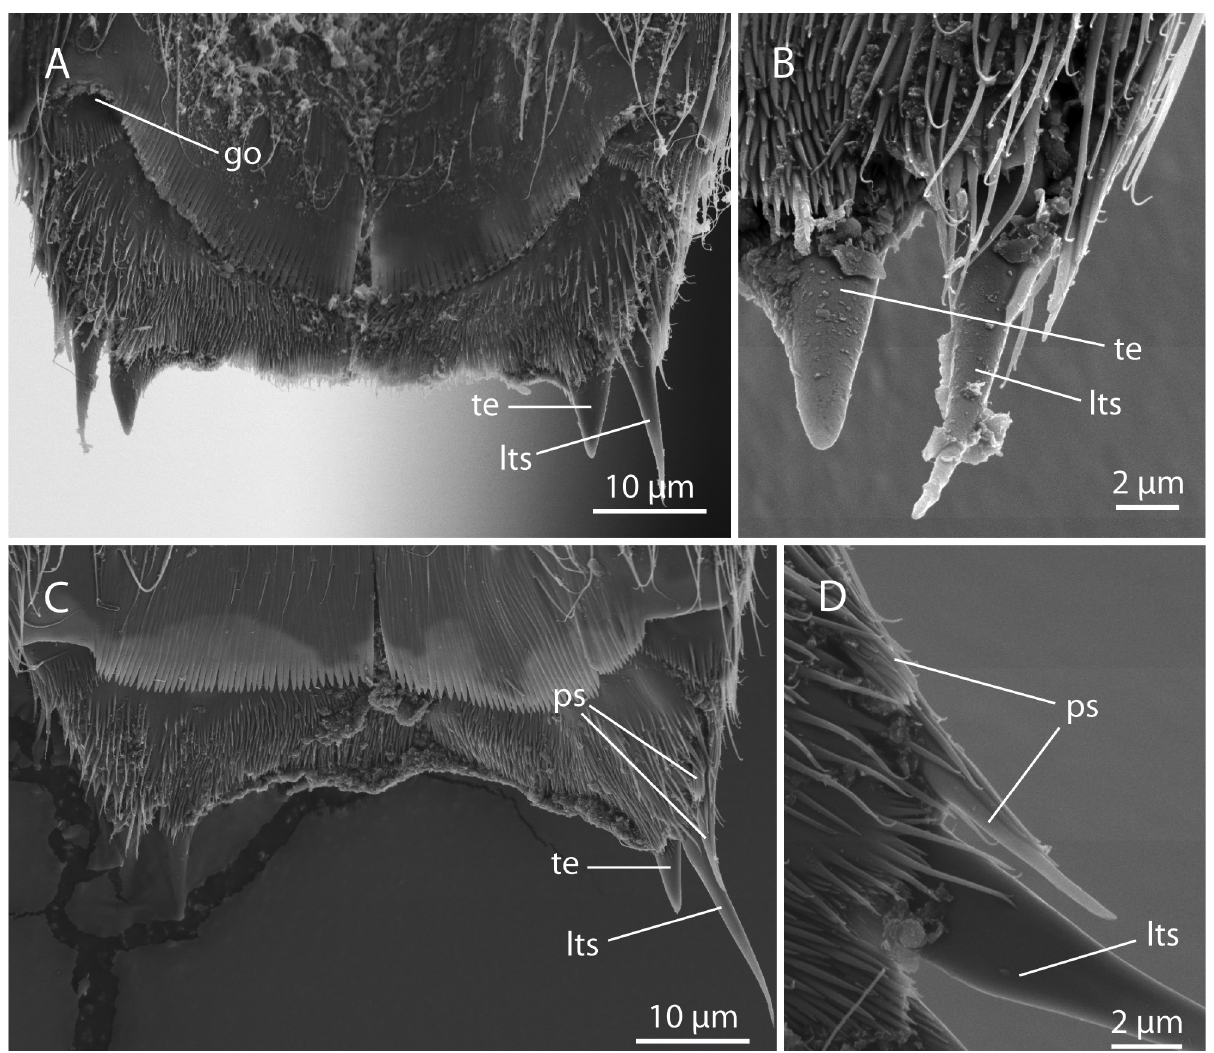
Fig . 5. – Scanning electron micrographs of terminal segments in Echinoderes rex n. sp. A: Segments 10 to 11 in female, ventral view. B: Detail from segment 11 in female. C: Segments 10 to 11 in male, ventral view. D: Detail from segment 11 in male. Abbreviations: go, gonopore opening; lts, lateral terminal spine; ps, penile spine; te, tergal